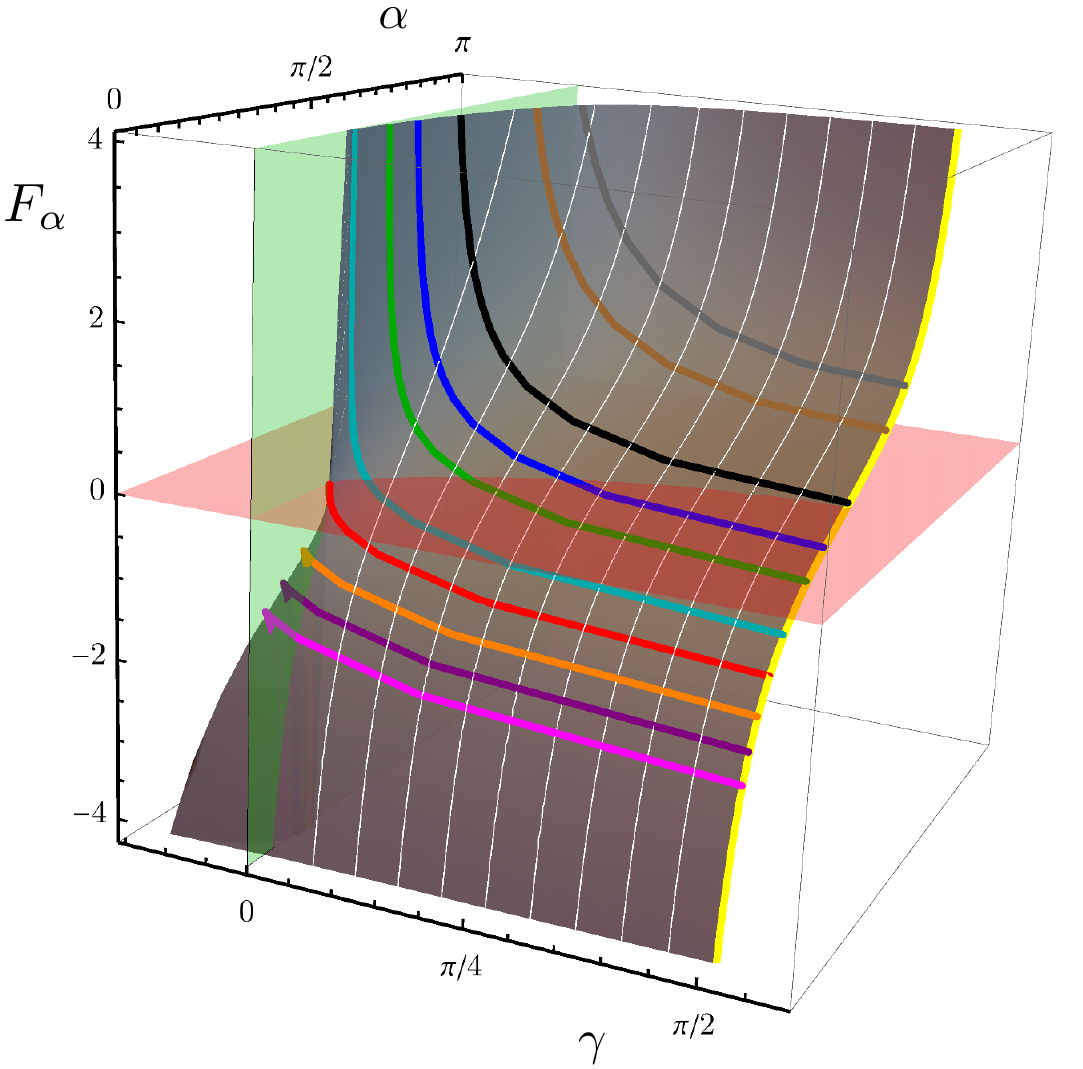
Figure 15 . The corner function F (cid:11) ( (cid:13) ) given by (6.5) and (6.10) in terms of (cid:13) 2 (0 ; (cid:25)= 2] and (cid:11) 2 (0 ; (cid:25) ) (grey surface). The solid curves corresponding to the (cid:11) = const sections are the same ones shown in (cid:12)gure 14, with the same colour code. The section (cid:13) = (cid:25)= 2 (yellow solid curve) is (5.2). In the left panel of (cid:12)gure 27 we depict the intersection between the grey surface and the red plane and in the right panel of (cid:12)gure 27 the intersection of the grey surface with the green plane is shown. In (cid:12)gure 14 the curves corresponding to the critical value (cid:11) = (cid:11) (red curve) given c by (5.6) and to (cid:11) = (cid:25)= 2 (black curve) have been highlighted by employing thicker lines because these values separate the range of (cid:11) 2 (0 ; (cid:25) ) into three intervals for (cid:11) where the corner function F ( (cid:13) ) has di(cid:11)erent features. In particular, when (cid:11) > (cid:25)= 2 we have that (cid:11) F ( (cid:13) ) > 0, while when (cid:11) 6 (cid:11) we have that F ( (cid:13) ) 6 0. In the intermediate range (cid:11) 2 (cid:11) c (cid:11) ( (cid:11) ; (cid:25)= 2) the corner function does not have a de(cid:12)nite sign in the whole range (cid:13) 2 (0 ; (cid:25)= 2] c and, being F 0 ( (cid:13) ) < 0, it has a unique zero (cid:13) = (cid:13) . The value (cid:13) in terms of (cid:11) 2 [ (cid:11) ; (cid:25)= 2] 0 0 c (cid:11) found numerically is shown in the left panel of (cid:12)gure 27.